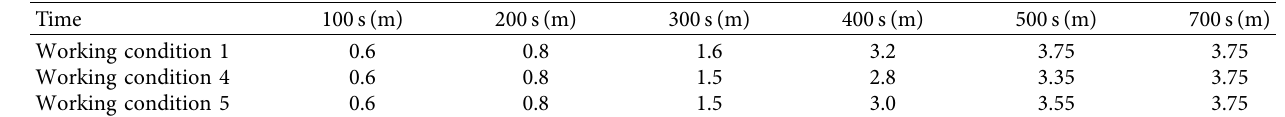
Table 5: Comparison of smoke layer thickness under working conditions 1, 4, and